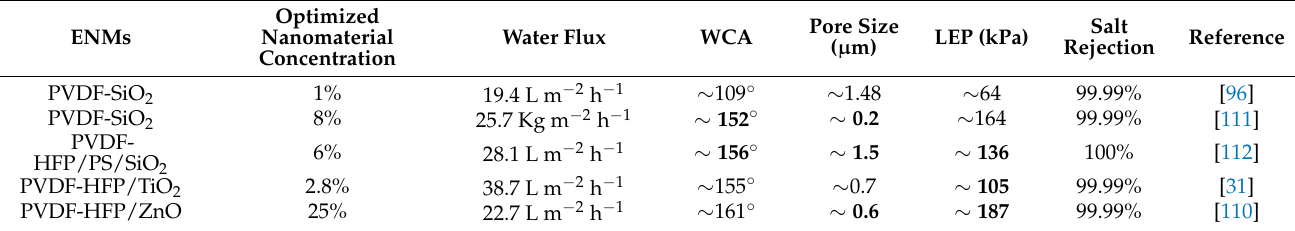
Table 3. Characteristics and MD flux of ENMs incorporated with SiO 2 , TiO 2 , and zeolite for